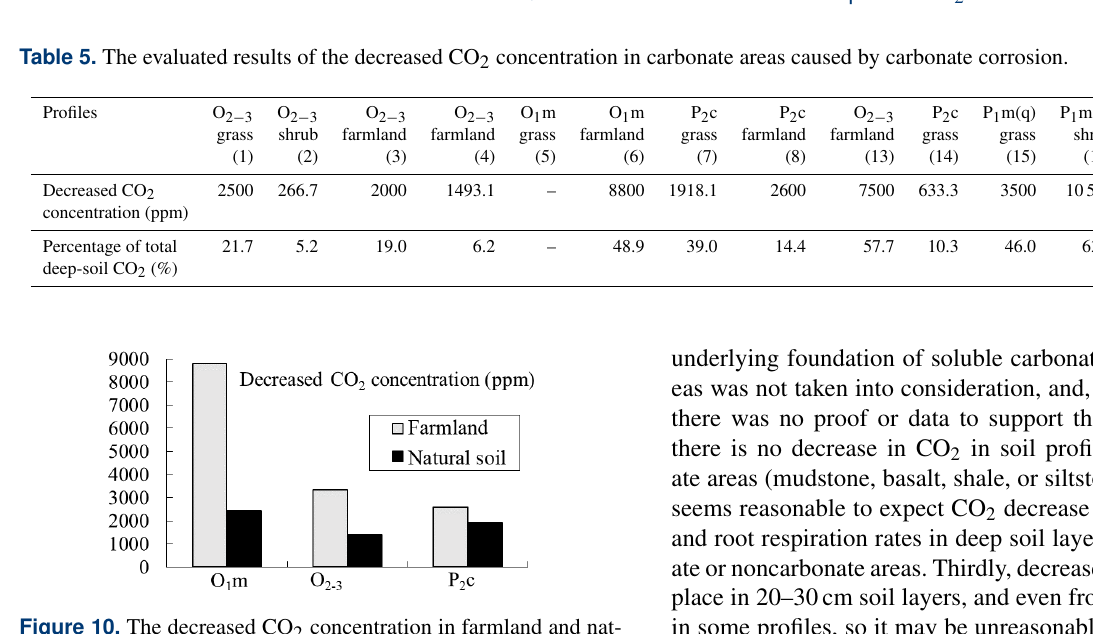
Figure 10. The decreased CO 2 concentration in farmland and nat- ural soil of the same stratigraphic